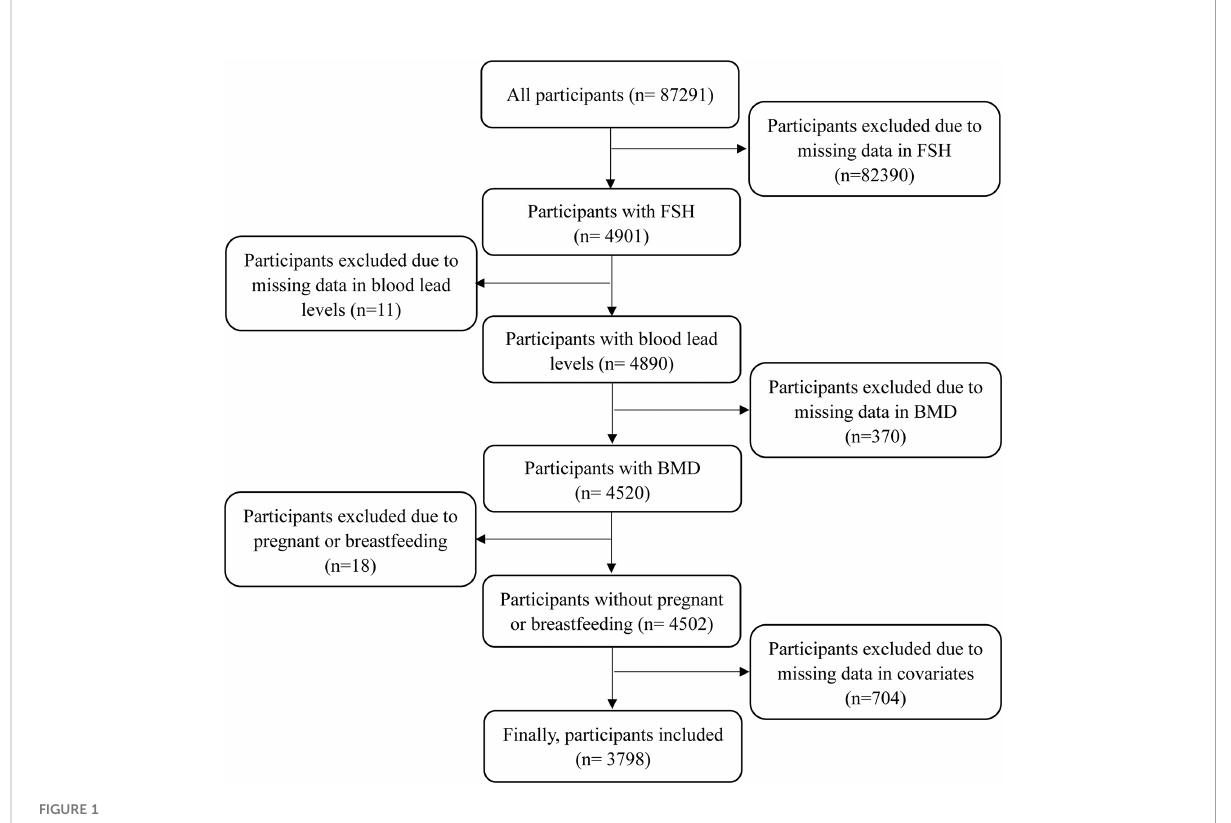
FIGURE 1 The fl ow chart of participants